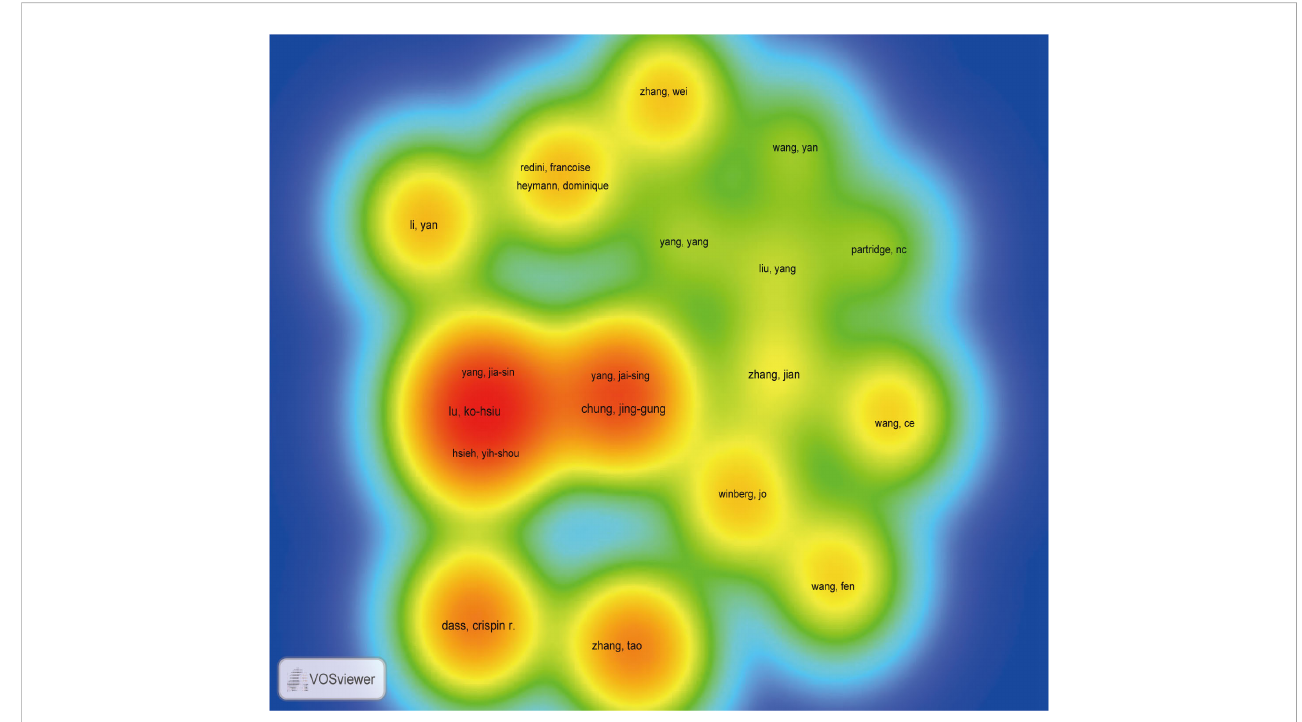
(blue) is mainly related to the role of MMP in OS and includes 25 keywords, such as EMT, breast-cancer, growth and PI3K/AKT. Cluster 3 (green) focuses on MMP-OS and contains 13 keywords, including OS, invasion and migration, proliferation, apoptosis.